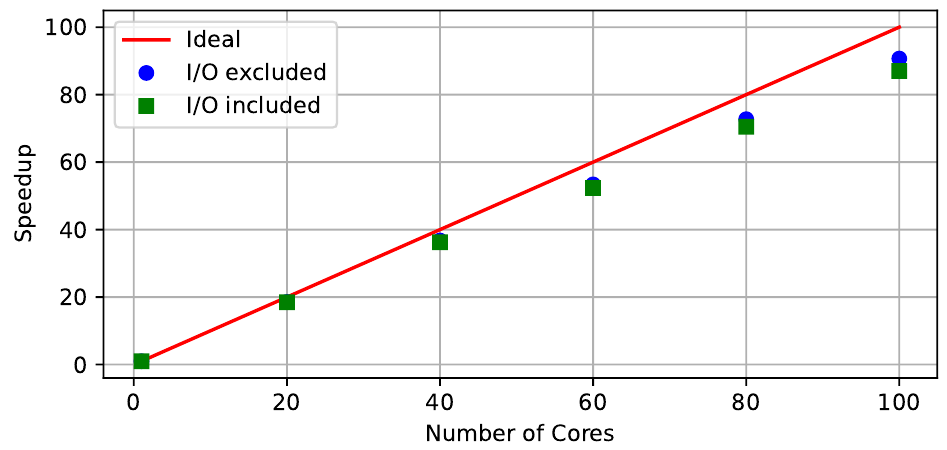
Figure 23. Speedup of the third-order solver for generating Figure 22.